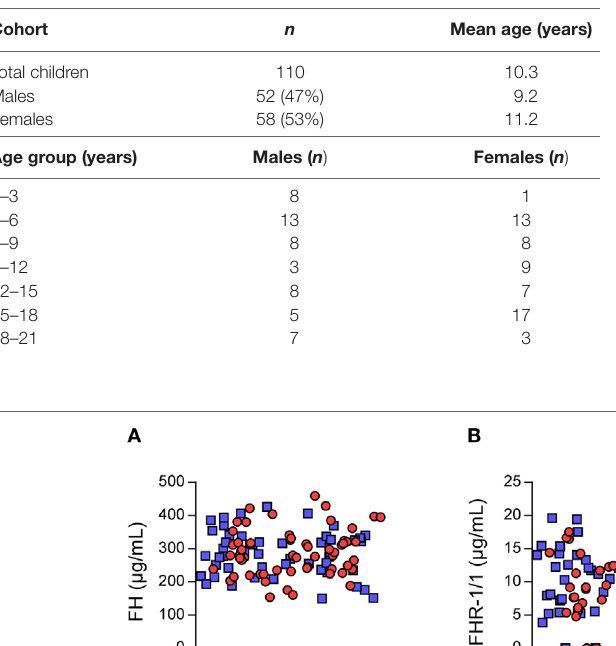
Table 1 | General cohort characteristics.